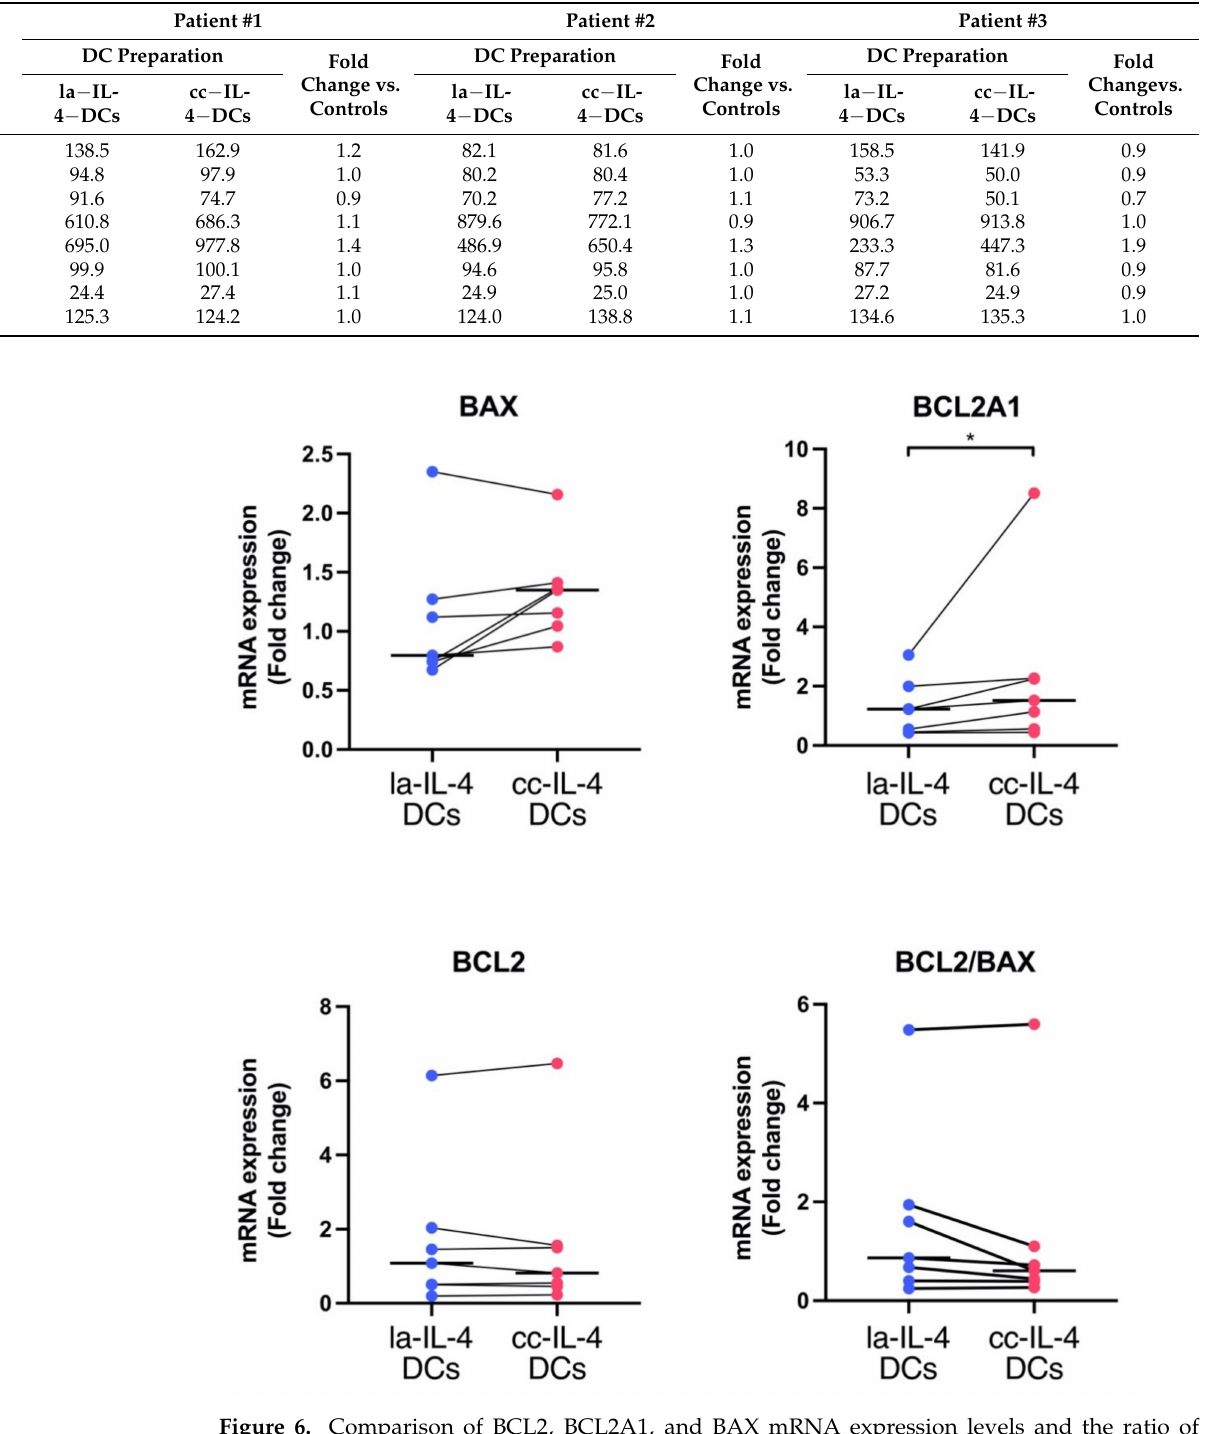
Figure 6. Comparison of BCL2, BCL2A1, and BAX mRNA expression levels and the ratio of BCL2/BAX expression in DCs matured in low − adherence and cluster − controlled dishes. After 24 h of maturation, the gene levels of BCL2, BCL2A1, and BAX were detected using real − time PCR analy- sis in low − adherent IL-4 − DCs (la − IL-4 − DCs) and cluster − controlled IL-4 − DCs (cc − IL-4 − DCs). The horizontal bars in graphs show the median of each gene expression experiment conducted in duplicate ( n = 7). * p <